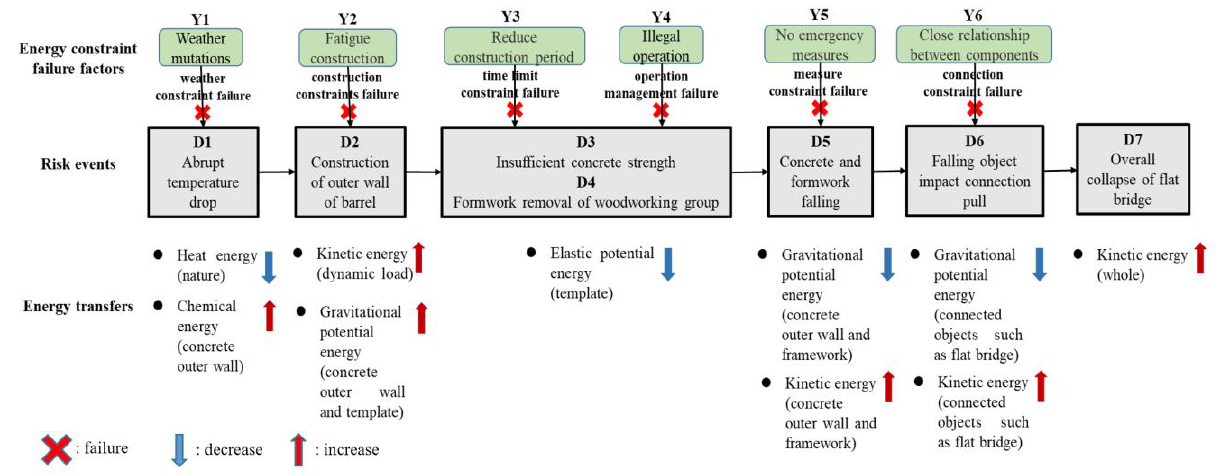
Figure 5. Evolution model of the energy constraint failure analysis for the FPCA.